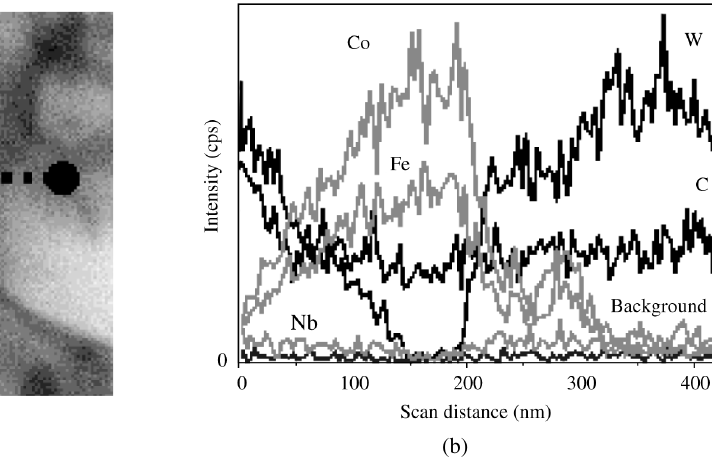
Figure 4. STEM image and corresponding EDS line scan.